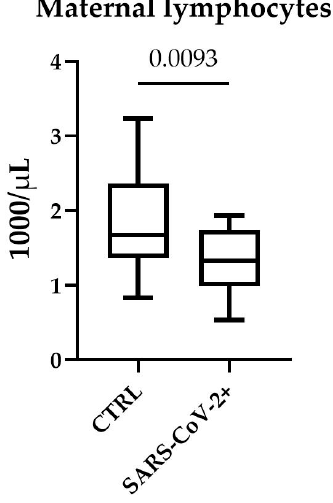
Figure 1. Lymphocyte count in maternal blood. Lymphocytes were counted in EDTA blood using ADVIA 2 analyzer. Lymphocyte concentration is expressed as 1000/ µ L. Box plots denote median and 25th to 75th percentiles (boxes) and min-to-max whiskers. The p value was evaluated using unpaired t